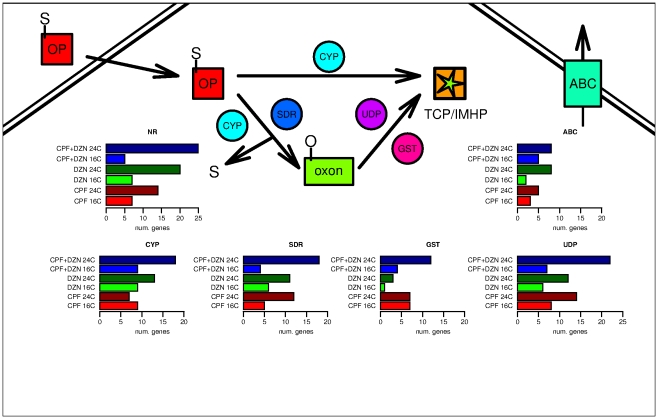
Effects of organophosphate pesticides (OPs) on detoxification genes.Transport of OPs inside the cell activates transcription of nuclear receptor (NR) genes and regulates expression of genes involved in detoxification. An initial phase of CPF and DZN detoxification starts with cytochrome P450 enzymes (CYPs) and short chain dehydrogenases (SDR) enzymes transforming the toxicants into an oxygenated form called oxon-OP (oxon). This highly toxic intermediate metabolite is effectively detoxified by hydrolysis mediated by UDP-glucuronosyl transferases (UGT) and glutathione-S-transferases (GST) enzymes. The final inactive compound of CPF and DZN are 3,5,6-trichloro-2-pyridinol (TCP) and 2-isopropyl-4-methyl-6-hydroxypyrimidine (IMHP), respectively. ABC-transporters (ABC) transport metabolites during the detoxification [28], [29]. The graphs show the number of detoxification genes affected by each toxicant at both temperatures.